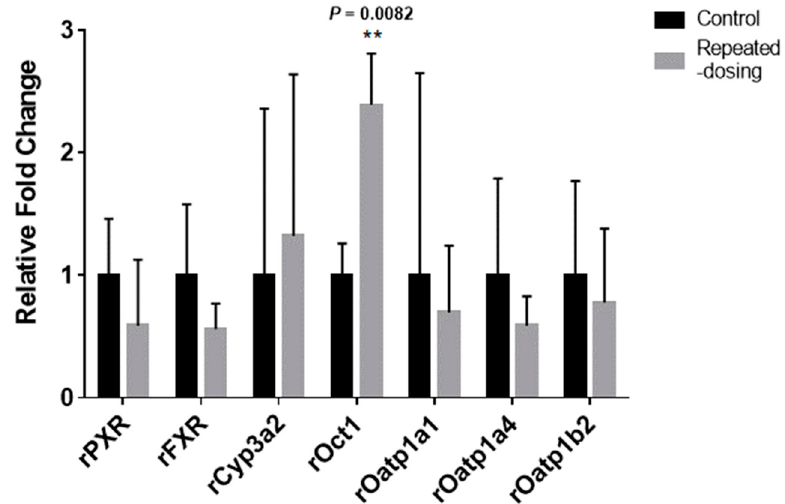
Figure 10. The relative expression of representative nuclear receptors, hepatic uptake transporters, and metabolic enzymes in the liver. The repeated-dosing group mRNA levels were expressed as a relative fold change compared to the control group (means ± the standard error of the mean). A Student’s t -test was employed to detect significant differences in the mRNA expression levels in the tissues (** p < 0.01).